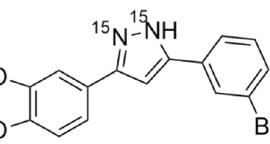
Fig.4|Anle138bformspolarinteractionswiththeproteinbackbonethatalter local structural fl uctuations in the proto fi lament. a Polar contacts between anle138b atoms (indicated by arrows) and protein backbone atoms (blue circles — amide nitrogen; red circles — carbonyl oxygen) observed in MD simulations for inward- (yellow) and outward-facing (green) internal binding poses. b Contact probabilities for polar interactions with backbone atoms of individual residues for polar interactions de fi ned in a . Scale bars (right) indicate contact probabilities. c Tubular cavity viewed up close down the long axis of the α -synuclein